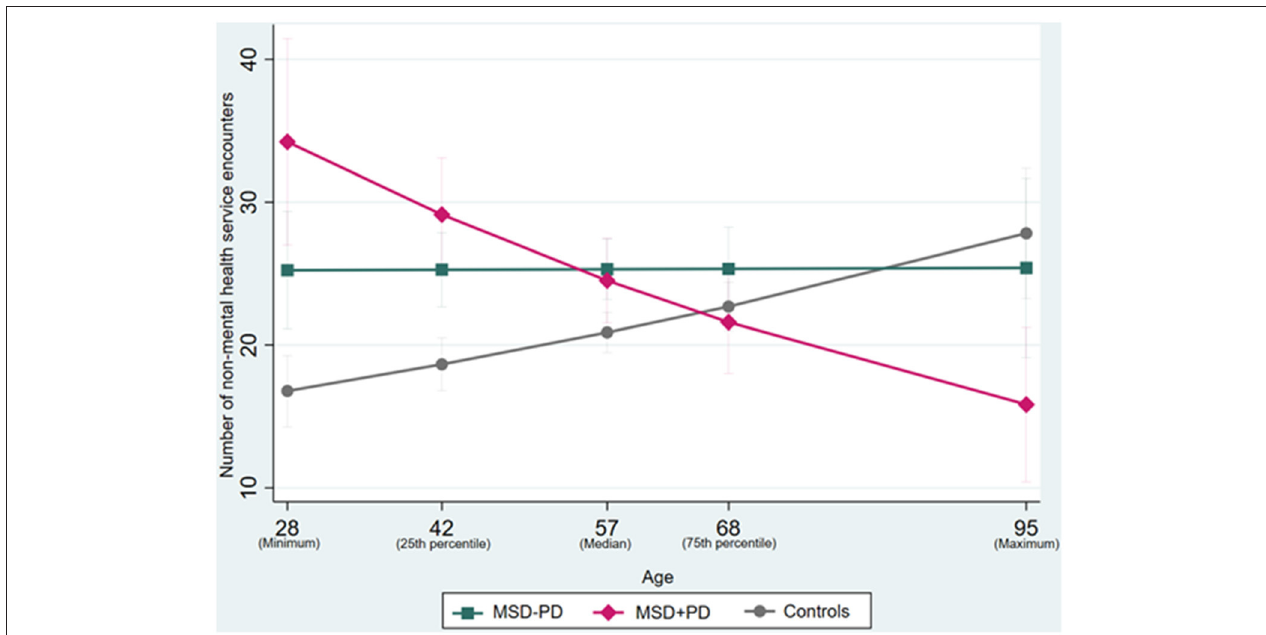
FIGURE 2 | Interaction effects between age and study groups status for non-mental health service utilization. MSD, Mental state disorder; PD, Personality Disorder.